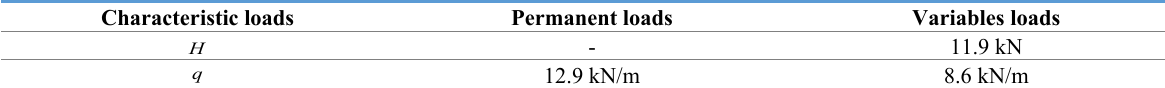
Table 3. Characteristic loads - Example